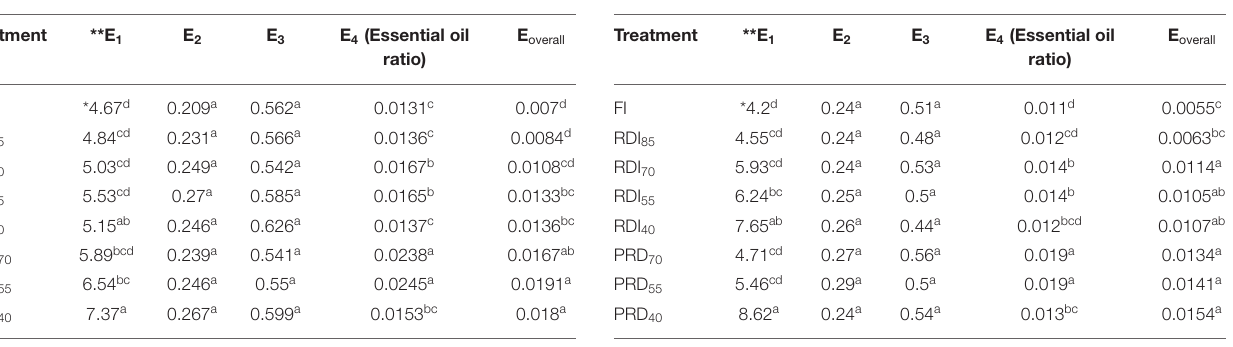
TABLE 4 | The efficiency of each step in an essential oil production process in cutting season